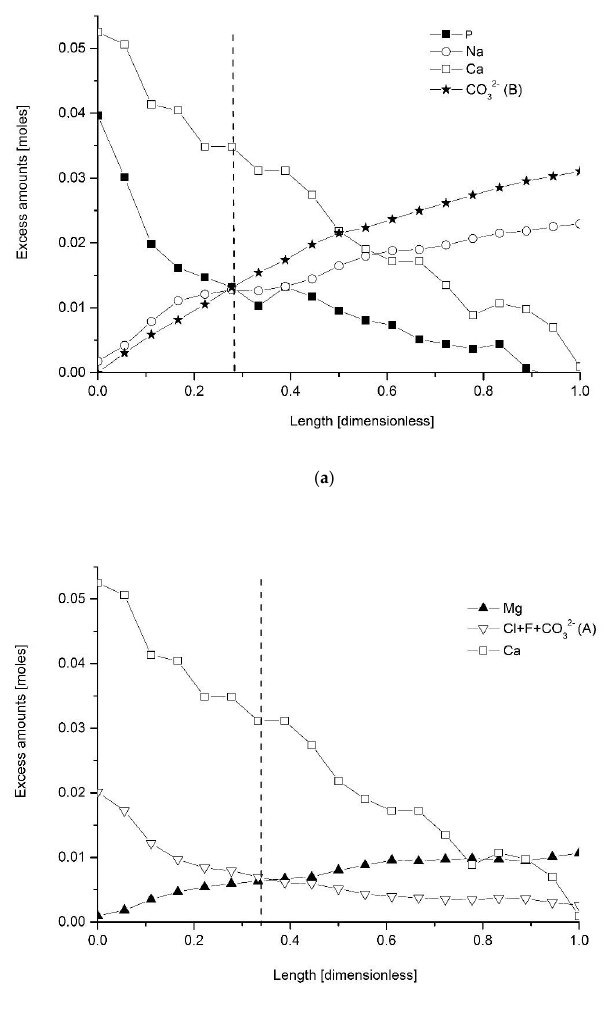
Figure 1. The concentration spatial profiles of ( a ) the excessive content of P, Ca, Na and CO 32− (B) as calculated in excessive molar values (see text) against the dimensionless distance, calculated from the enamel surface (left side, position 0) to DEJ (right side of the figure, position 1); ( b ) the same for the excessive amounts of Ca, Mg and Cl + F + CO 32− (A), with missing profile of OH − ions. Dotted lines show the intersection points of curves, roughly in the same location. Capital A and B letters mean substitutions for CO 32− ions.